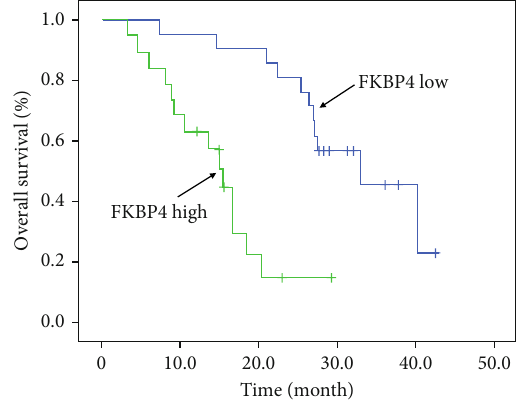
Figure 3: Survival analysis of patients with high and low FKBP4 expression groups; log-rank test, N = 40 , P < 0 : 001